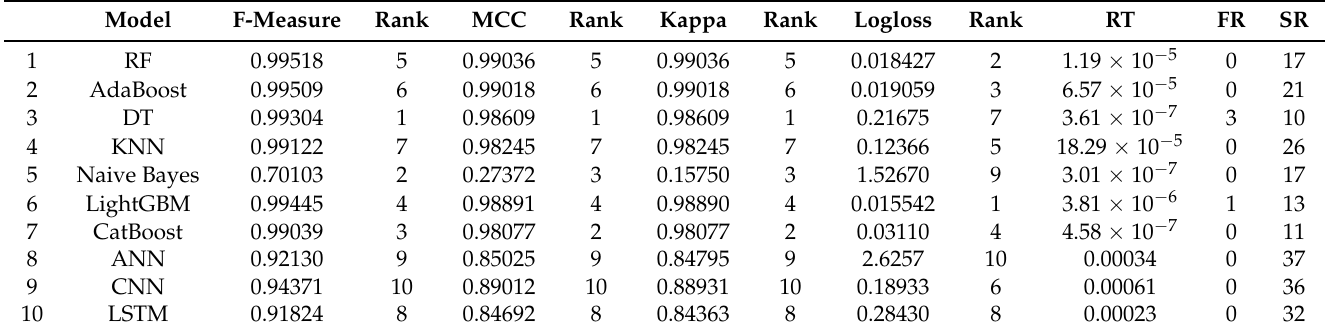
Table 7. Ranking of detection model using the Merged dataset for binary classification.